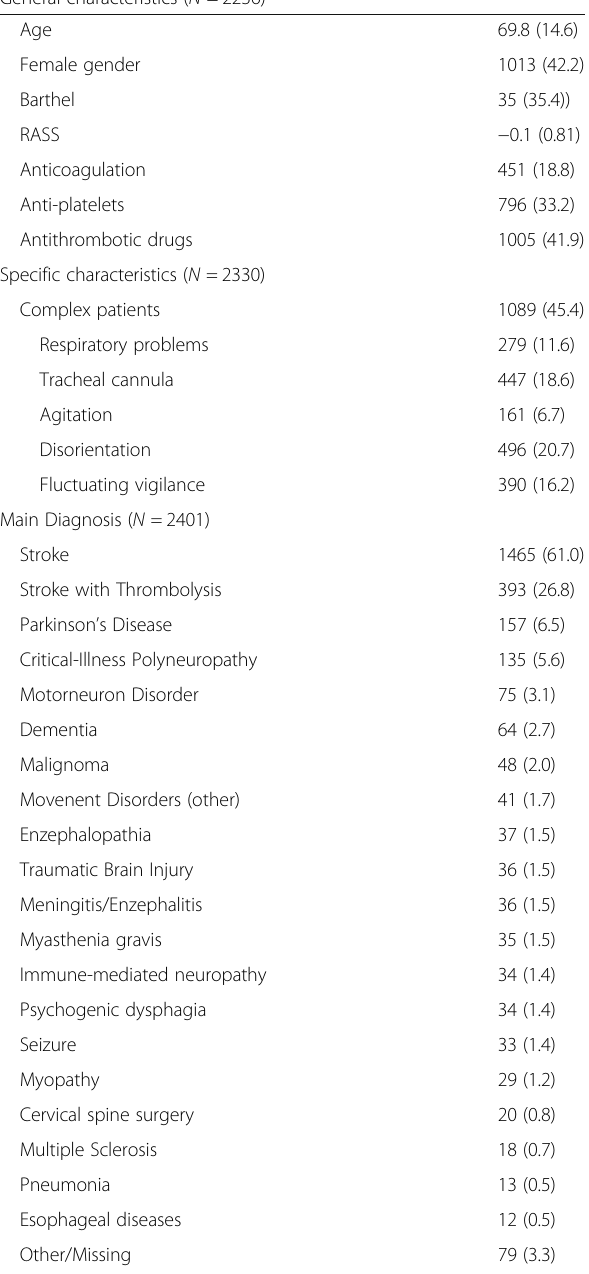
Table 1 Epidemiological and clinical characteristics of the patient cohort. Numbers in brackets give the number of patients with complete datasets with regards to the specific